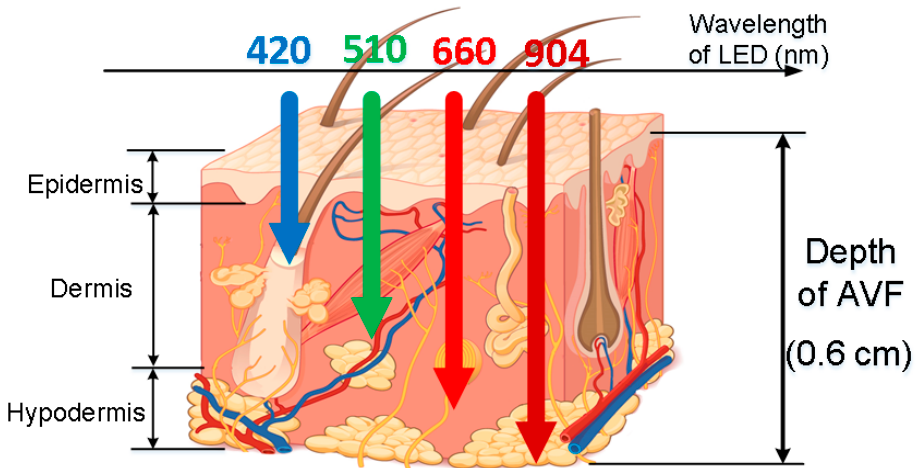
Figure 5. Generic light traces with different wavelengths, penetrating into skin tissues with different depth, where the typical depth of AVF (0.5–0.6 cm [1]) are corresponding to 904 nm wavelength (figure based on Reference [6]).